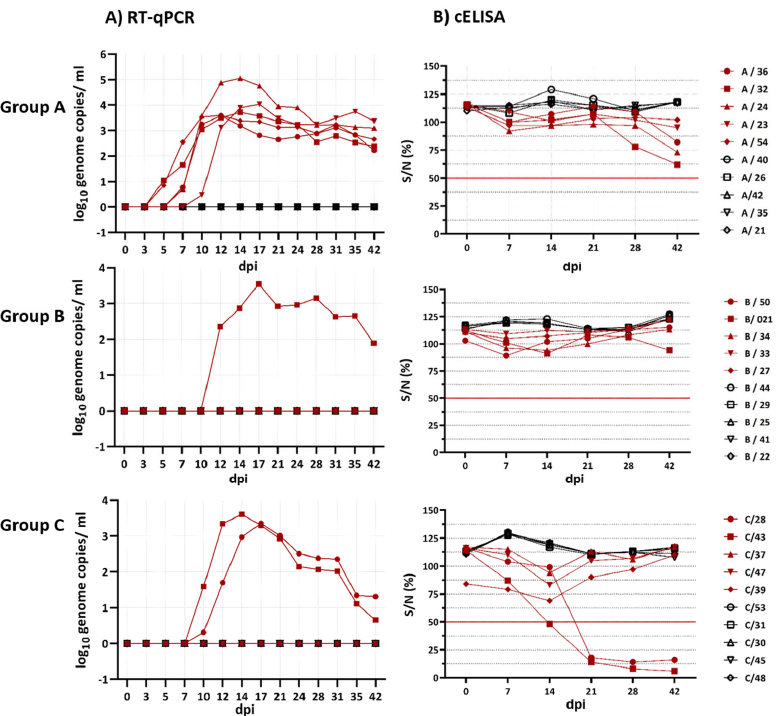
Figure 1. In total, five goats of group A were inoculated subcutaneously with BTV-33-MNG3/2016, five goats of group B with BTV-25-GER2018 and five goats of group C with BTV-8-GER2018 (in red). In each of the three groups, five control goats were kept (in black). ( A ) RT-qPCR results of the EDTA blood. ( B ) The cELISA results of the serum. The horizontal red line is the cut-off line (values ≤ 50 are considered positive; values ≥ 50 are considered negative). dpi = days post infection; S/N (%) = signal-to-noise ratio in